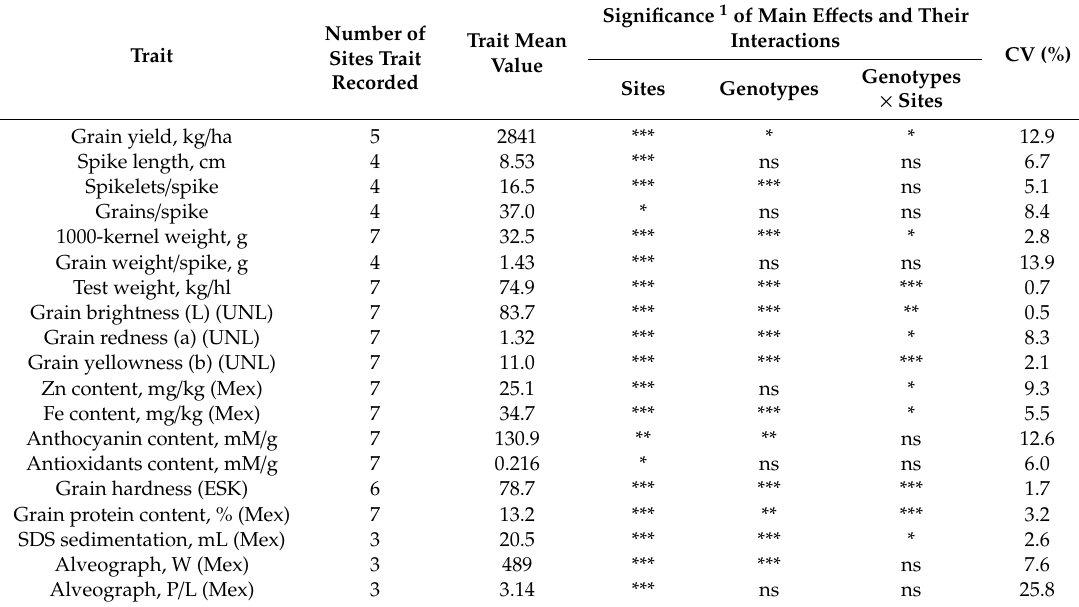
Table 3. Significance of main e ff ects and their interactions for di ff erent traits in purple grain isogenic lines across sites in